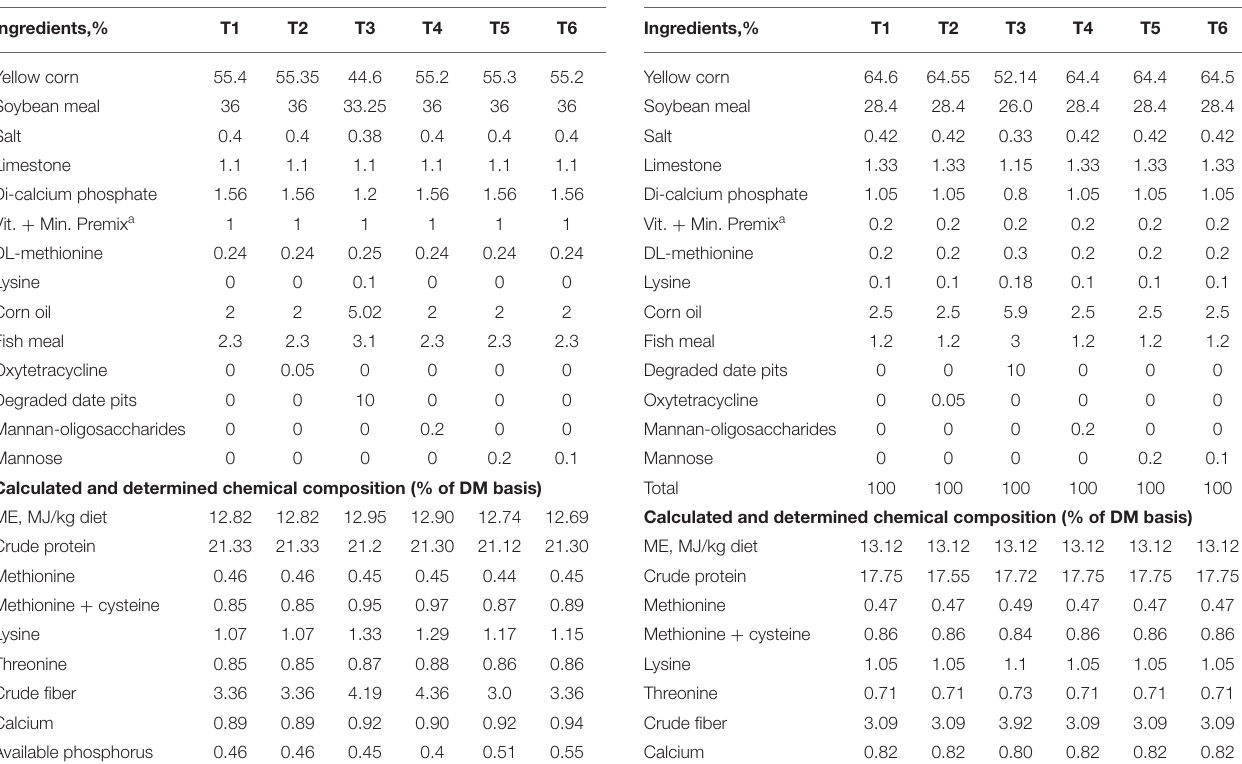
Available phosphorus